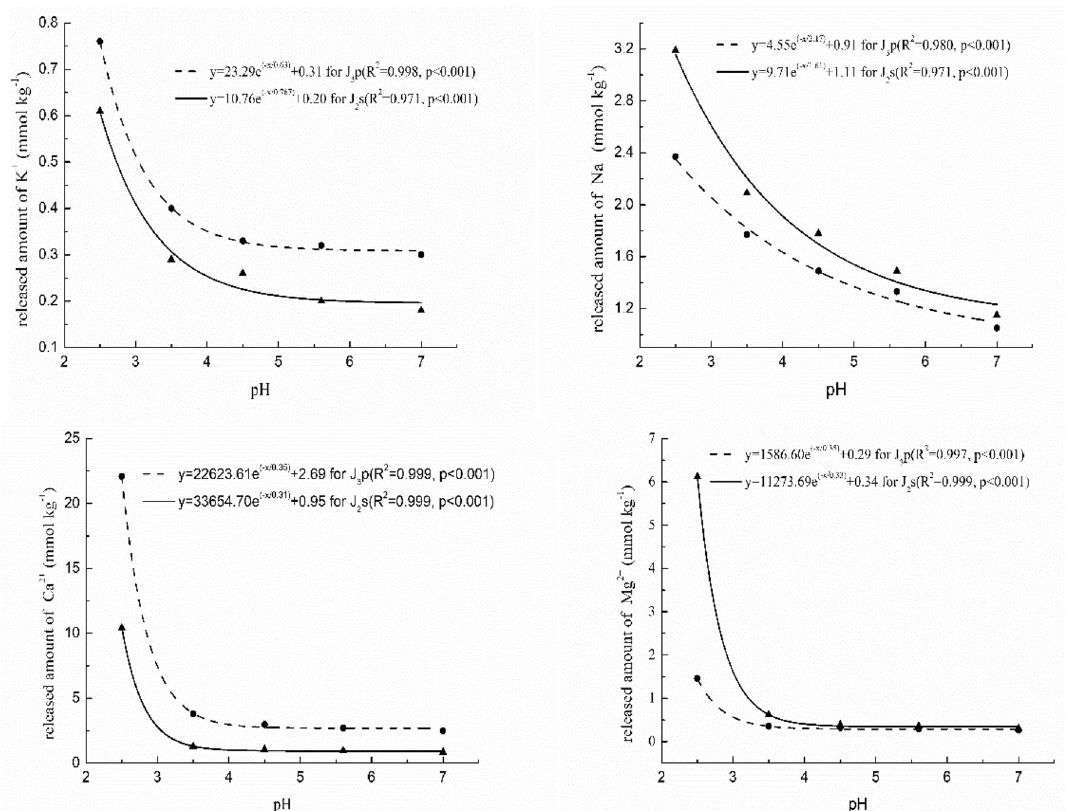
Figure 4. Relationship between the total cations (K + , Na + , Ca 2+ and Mg 2+ ) released and pH.